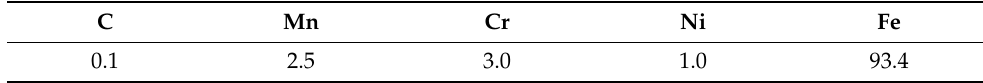
Table 1. Chemical composition of Nimax steel, wt %, steel standard.